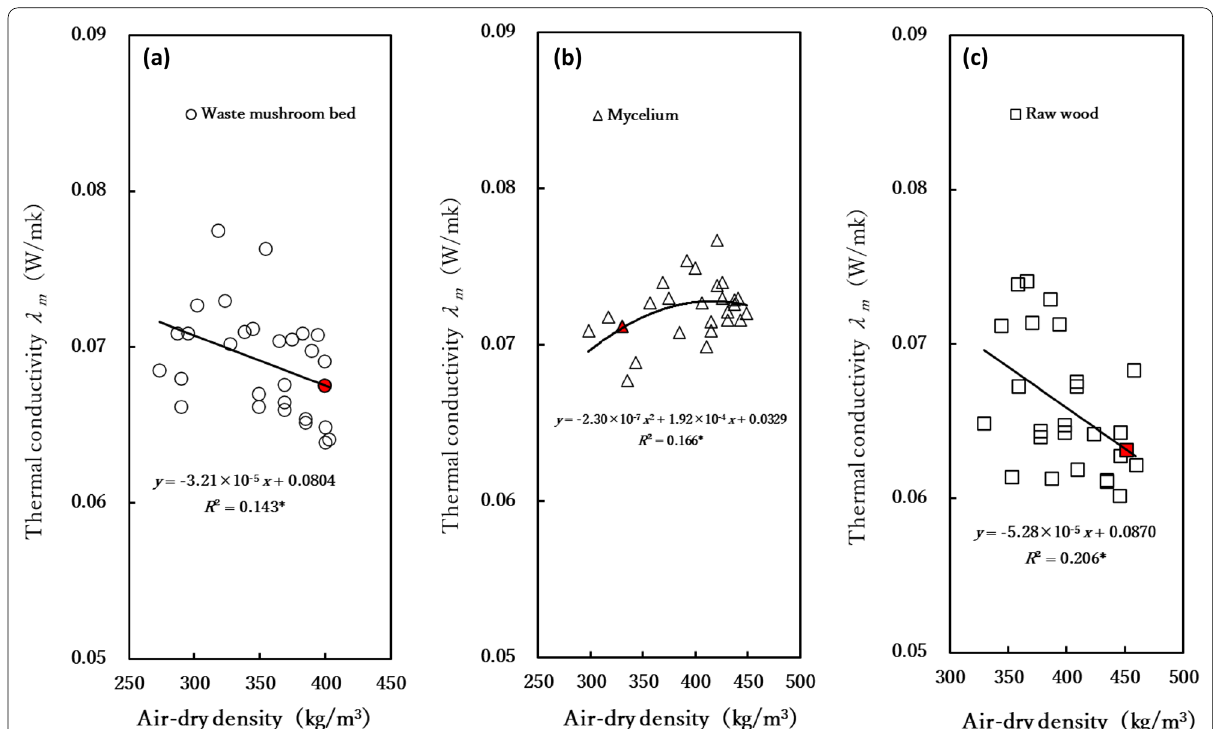
Fig. 6 Relationship between the air-dry density and thermal conductivity for the powder mat